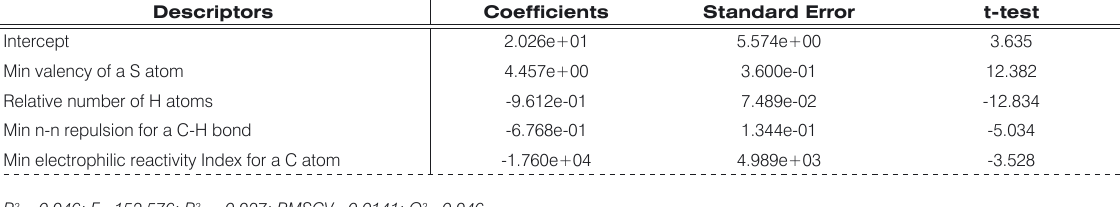
Table 2. Descriptors, Coefficients, Standard Error, and t-Test Values for the HM model